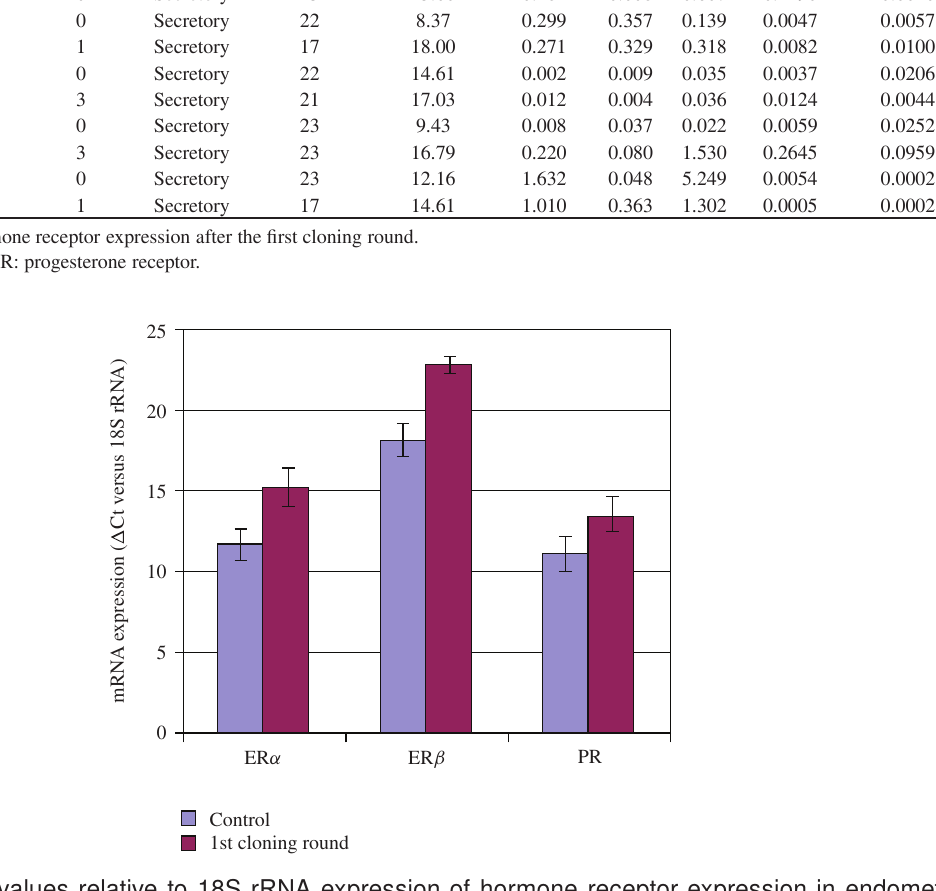
FIGURE 1: (cid:4) Ct values relative to 18S rRNA expression of hormone receptor expression in endometrial stroma cell cultures after the first cloning round. Please note that a higher (cid:4) Ct value corresponds to a comparably lower expression level. Error bars = SEM, n = 11